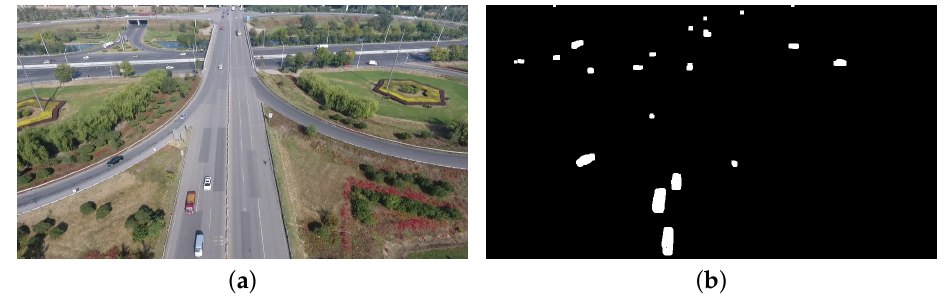
Figure 11. An example of post-processing(static background). Median filter is used to post-process the image. To suppress the noise contained in the segmented image, we chose the area of the object to be filtered: ( a ) the original image; and ( b ) the final result of detector.